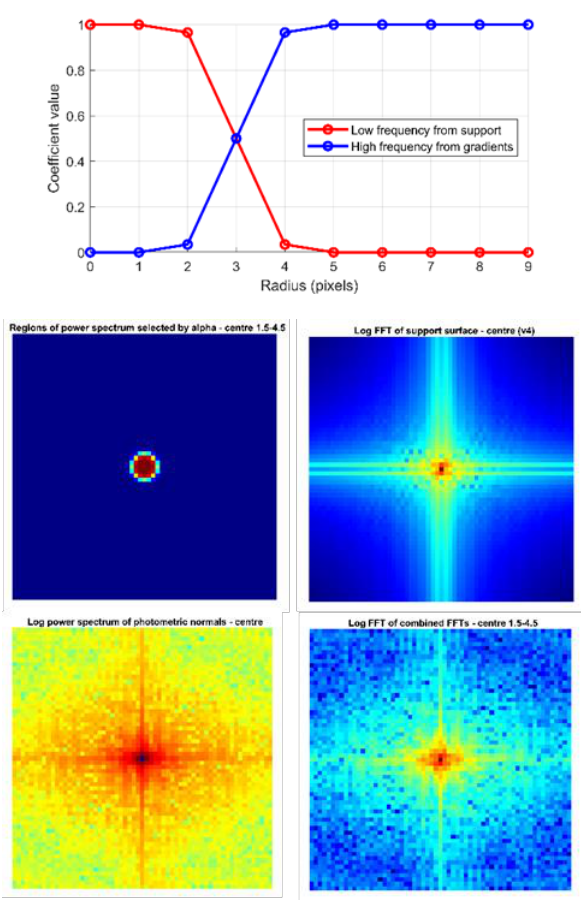
Figure 16. Top: Reconstructed surface of whole image area, blending low frequency from support with high frequency from photometric normals. Centre: Detail of the reconstructed surface of circular retro target at left of the plate. Bottom: Elevation of a cross-section of the reconstructed surface of the target (red) above the support surface (blue).